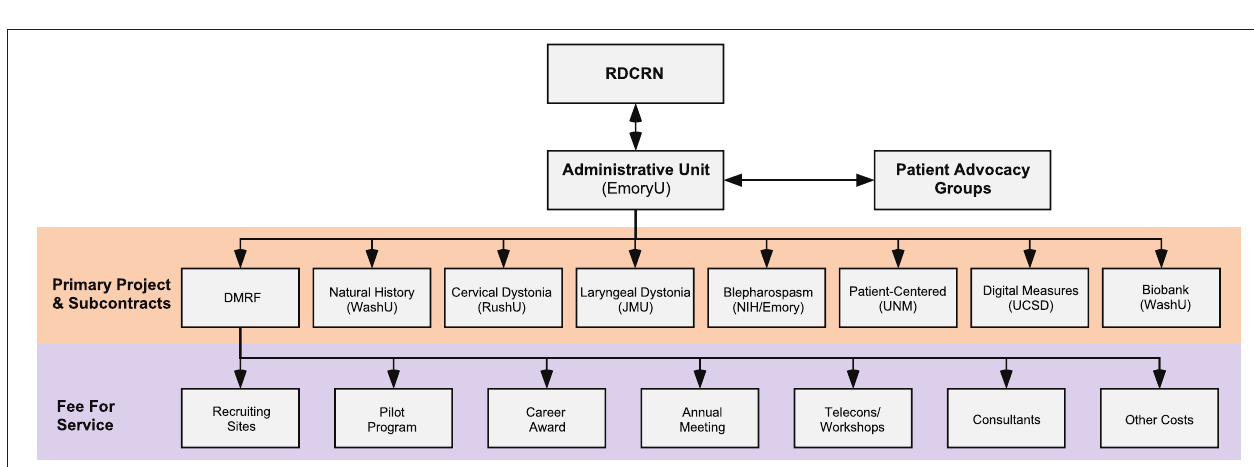
FIGURE 3 | Financial structure. The majority of funding comes from the NIH Rare Diseases Clinical Research Network (RDCRN), although some funding and other resources also come from Patient Advocacy Groups. The Administrative Unit at Emory University provides payments by direct subcontracts to sites that organize large international multicenter projects. The Administrative Unit also has a subcontract with the Dystonia Medical Research Foundation (DMRF), which is responsible for disbursing funds on a fee-for-service basis to Recruiting Sites (depending on numbers of subjects recruited), smaller projects (such as Pilot Grant Projects or Career Awards), meetings, consultants, and others. JMU, James Madison University; NIH, National Institutes of Health USA; NINDS, National Institute of Neurological Disorders and Stroke; RushU, Rush University; UCSD, University of California in San Diego; UNM, University of New Mexico; WashU, Washington University in St.